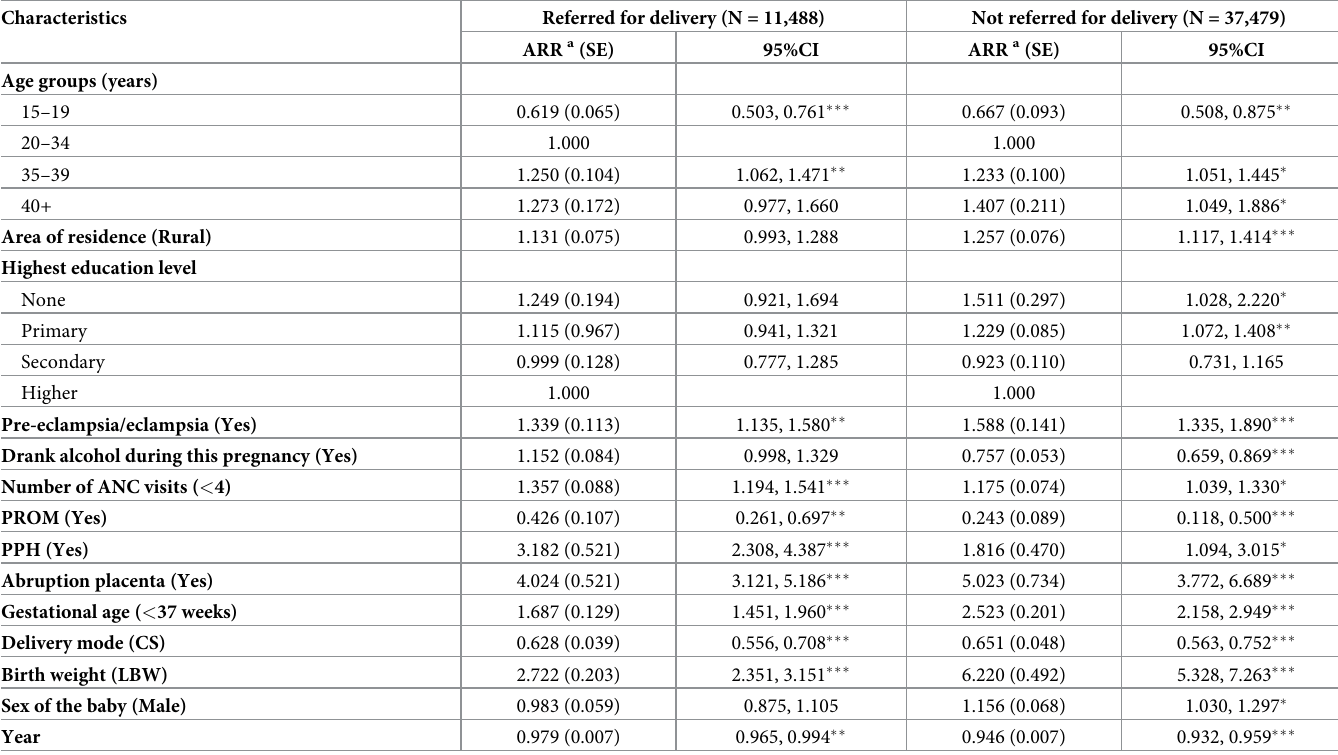
Table 6. Adjusted analysis showing predictors of perinatal death stratified by referral status.